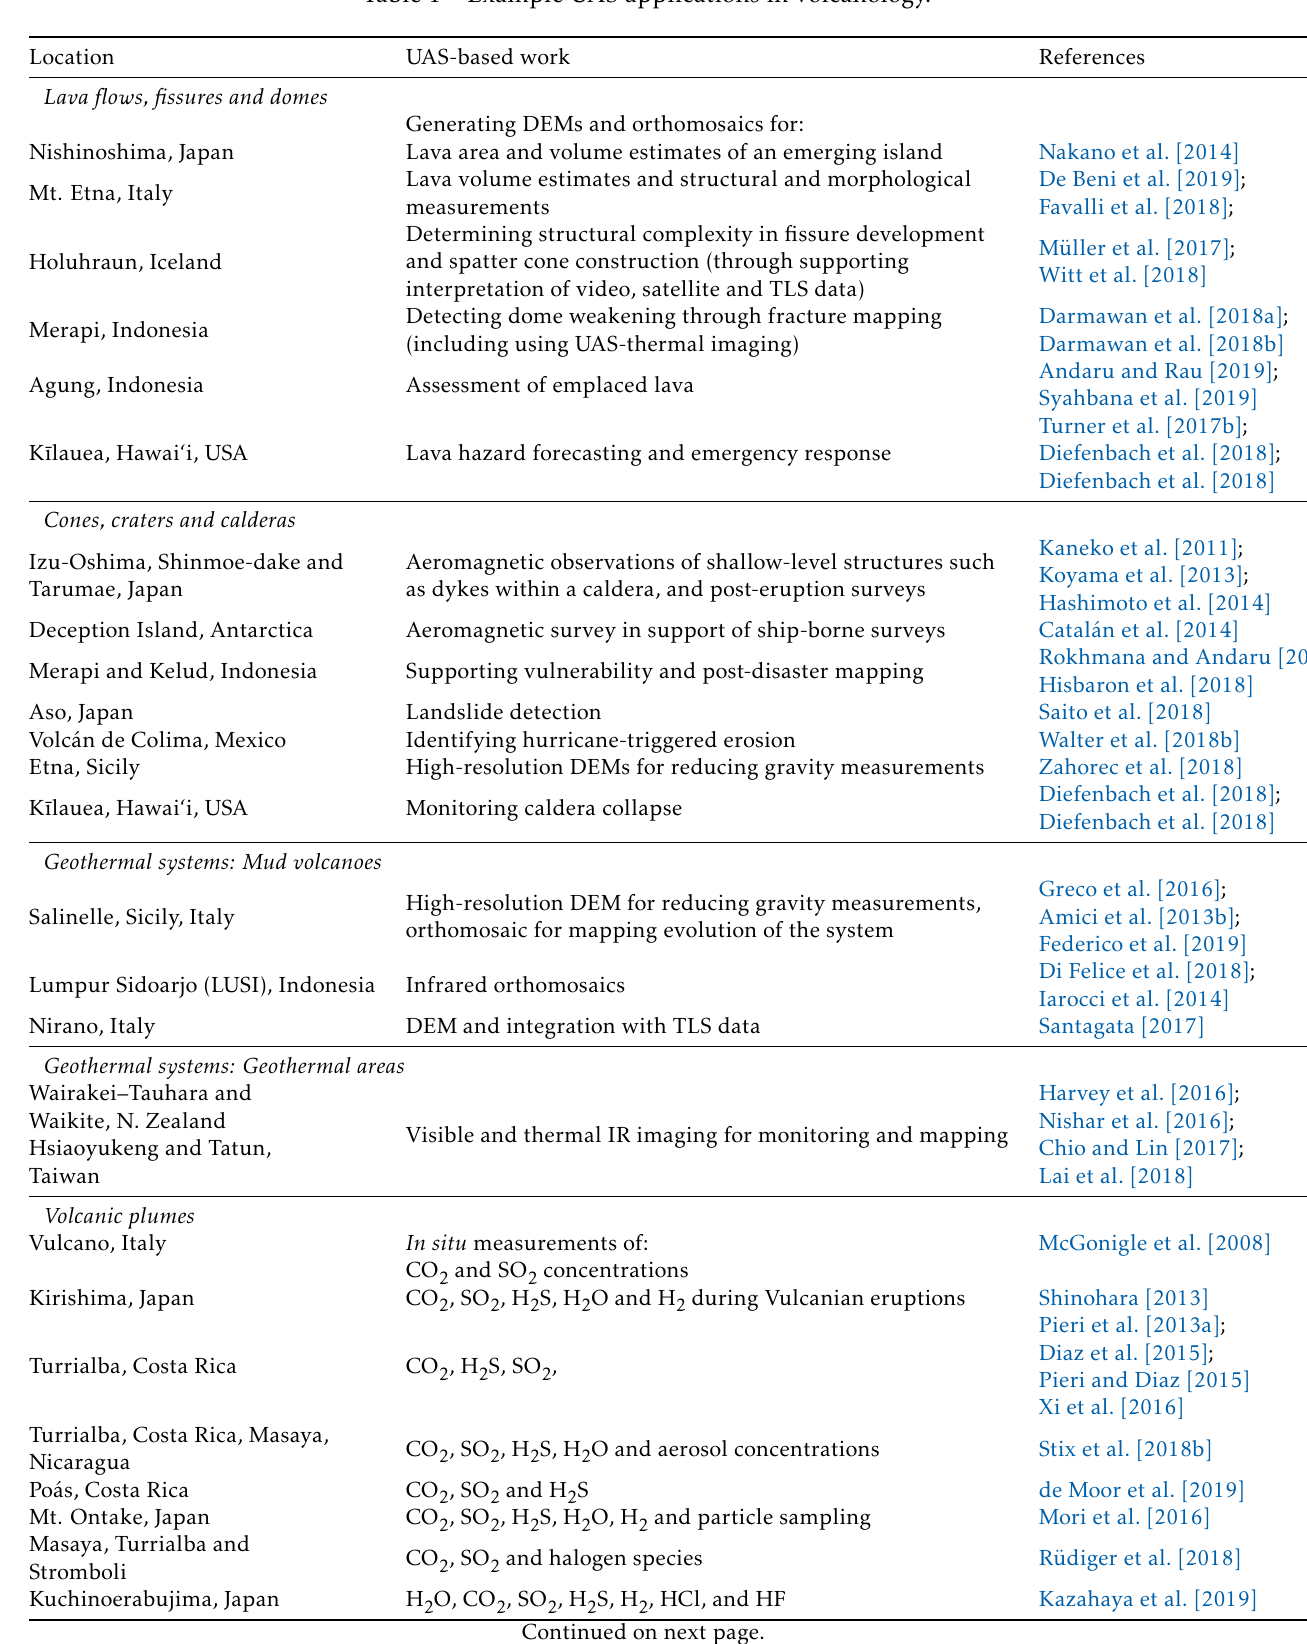
Table 1 – Example UAS applications in